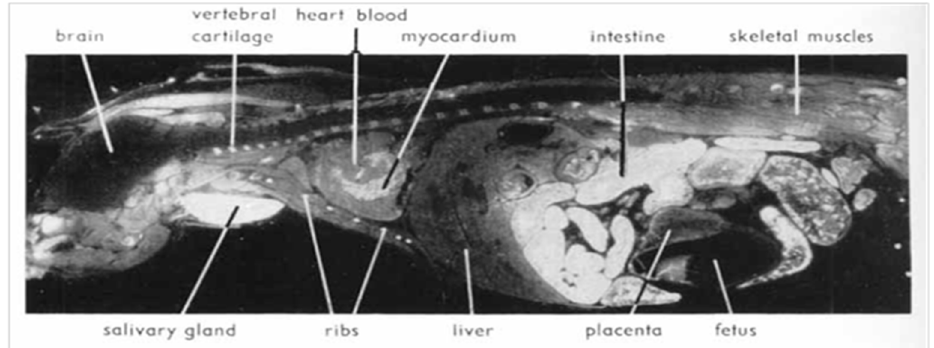
Figure 4. Autoradiograms showing the distribution of 137-Cs in a pregnant mouse 5 min after intravenous injection. White areas correspond to high radioactivity. High uptake in cartilaginous parts of ribs and vertebrae and in salivary gland and intestine. The pancreas shows the same high level of activity as the intestinal mucosa. (Reproduced from Nelson et al. [13] with permission of Acta Radiologica, 1961).